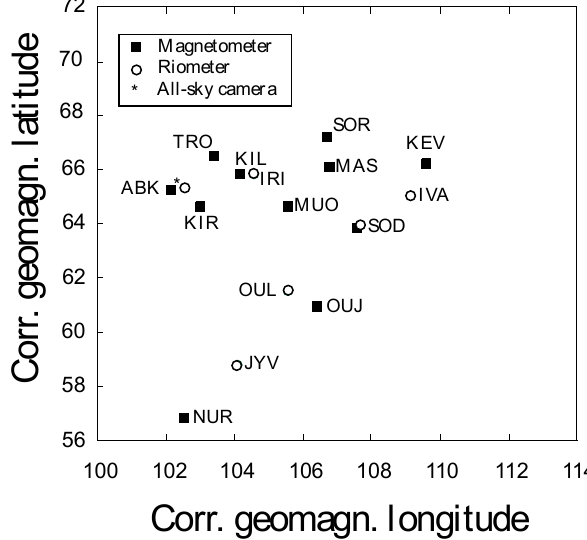
Fig. 1. A map showing the CGM latitudes and longitudes of the magnetometer and riometer